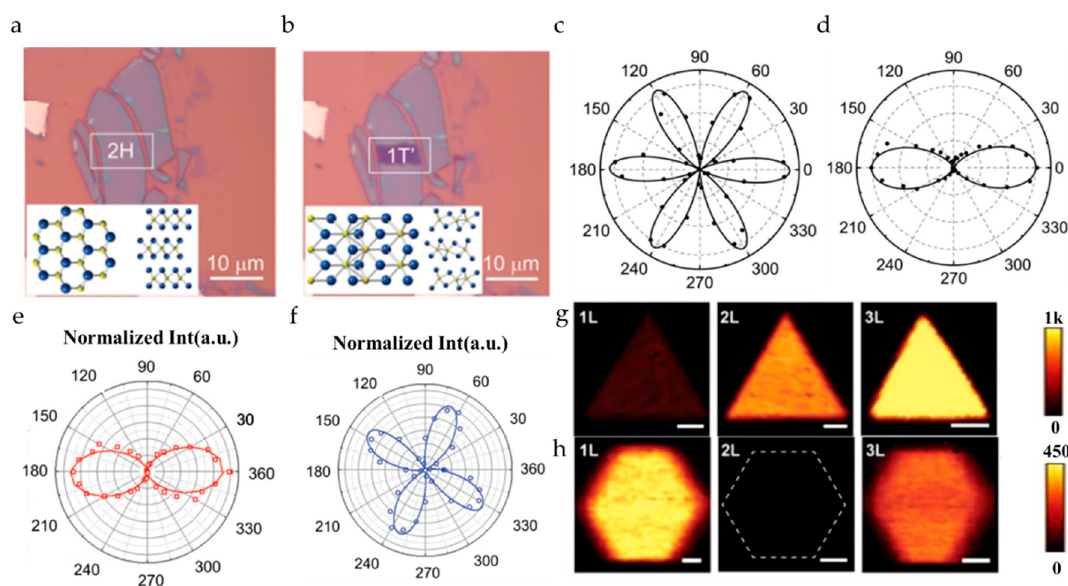
Figure 7. Optical microscope images of 2H-MoTe 2 flake ( a ) before ( b ) after laser irradiation over an area marked by the white box. Insets in two panels show the lattice structures of 2H and 1T ′ MoTe 2 . Reproduced from [44], with permission from John Wiley and Sons, 2018. Polar plots of the SHG intensities from the few-layer MoTe 2 ( c ) before and ( d ) after laser irradiation Reproduced from [44], with permission from John Wiley and Sons, 2018. Polar plots of SH intensity of ( e ) 1T’and ( f ) 2H MoTe 2 , respectively. Reproduced from [74], with permission from American Chemical Society,